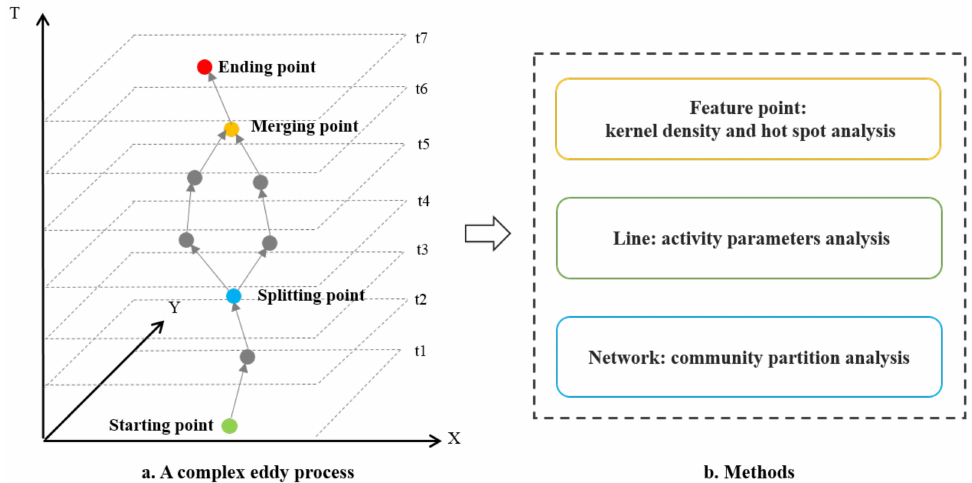
Figure 2. A diagram showing the structure of an eddy trajectory, which is represented as di ff erent objects (points, lines, and networks) ( a ), which were then examined using di ff erent methods ( b